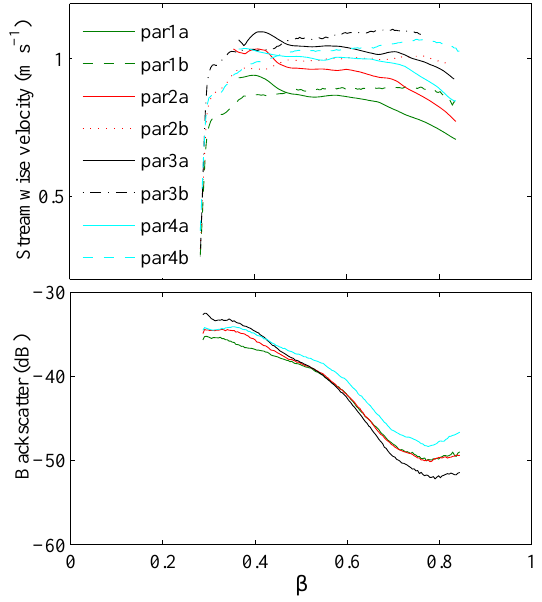
Fig. 3. Top panel: Comparison of streamwise velocity profiles es- timated from boat-mounted ADCP measurements (index a) and H- ADCP data (index b) during the surveys used for parameter assess- ment. Bottom panel: H-ADCP backscatter profiles, averaged over the three beams, for the surveys corresponding to the top panel. main lobes. Side lobes would raise the backscatter